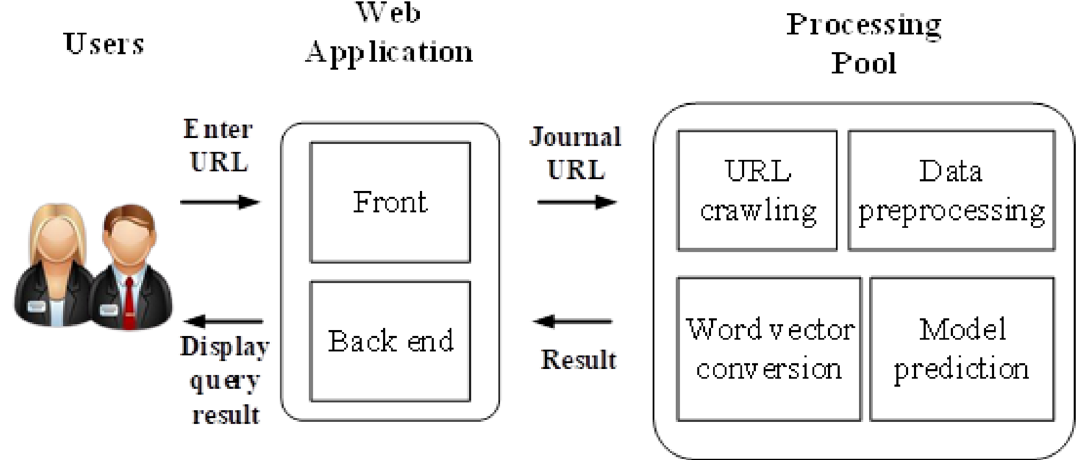
Figure 3. Proposed academic journal predatory checking (AJPC) system